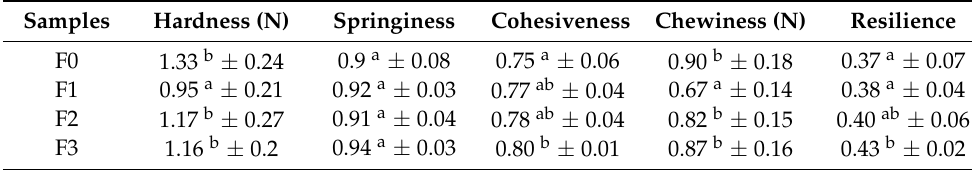
Table 4. TPA parameter values obtained in the muffins.